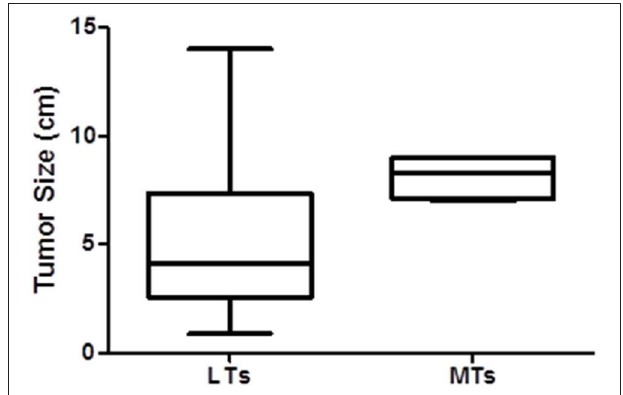
FIGURE 1 | The difference in tumor size between MT and LT SPNs displayed by a boxplot.